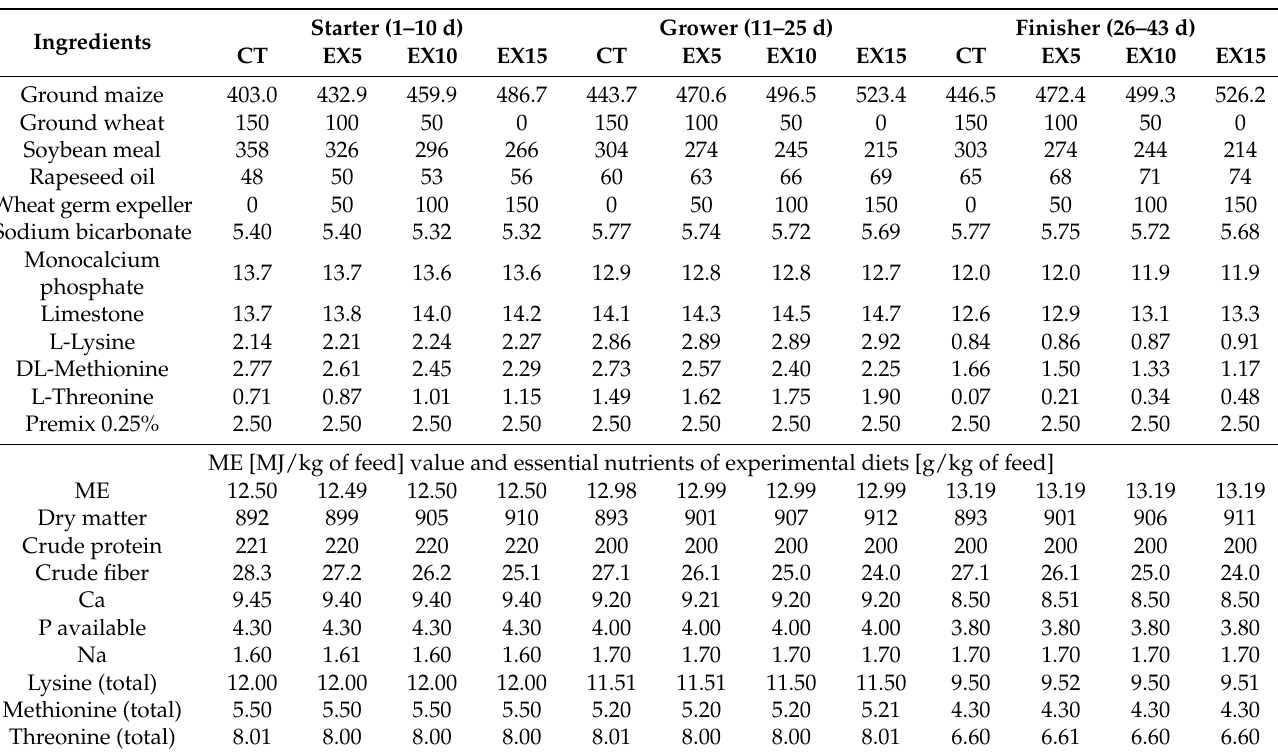
Abbreviations: CT, Control Treatment; EX5, Experimental diet with 5% wheat germ expeller; EX10, Experimental diet with 10% wheat germ expeller; EX15, Experimental diet with 15% wheat germ expeller. The content of additives added in the premix (0.25%) in 1 kg of the mixture: Vitamin A—8100 UI.; D3—3000 UI.; E—22.50 UI.; K3—1.25 mg; B1—1.25 mg. B2—4.60 mg; B6—2.20 mg; B12—0.02 mg; PP—20.0 mg; choline chloride—184.25 mg; calcium D-pantothenate—6.50 mg; folic acid—0.34 mg; biotin—0.10 mg; betaine; hydrochloride—41.89 mg; Cu—10 mg; Fe—30 mg; Zn—60 mg; Mn—70.40 mg; J—0.75 mg; Se—0.20 mg; Substances improving